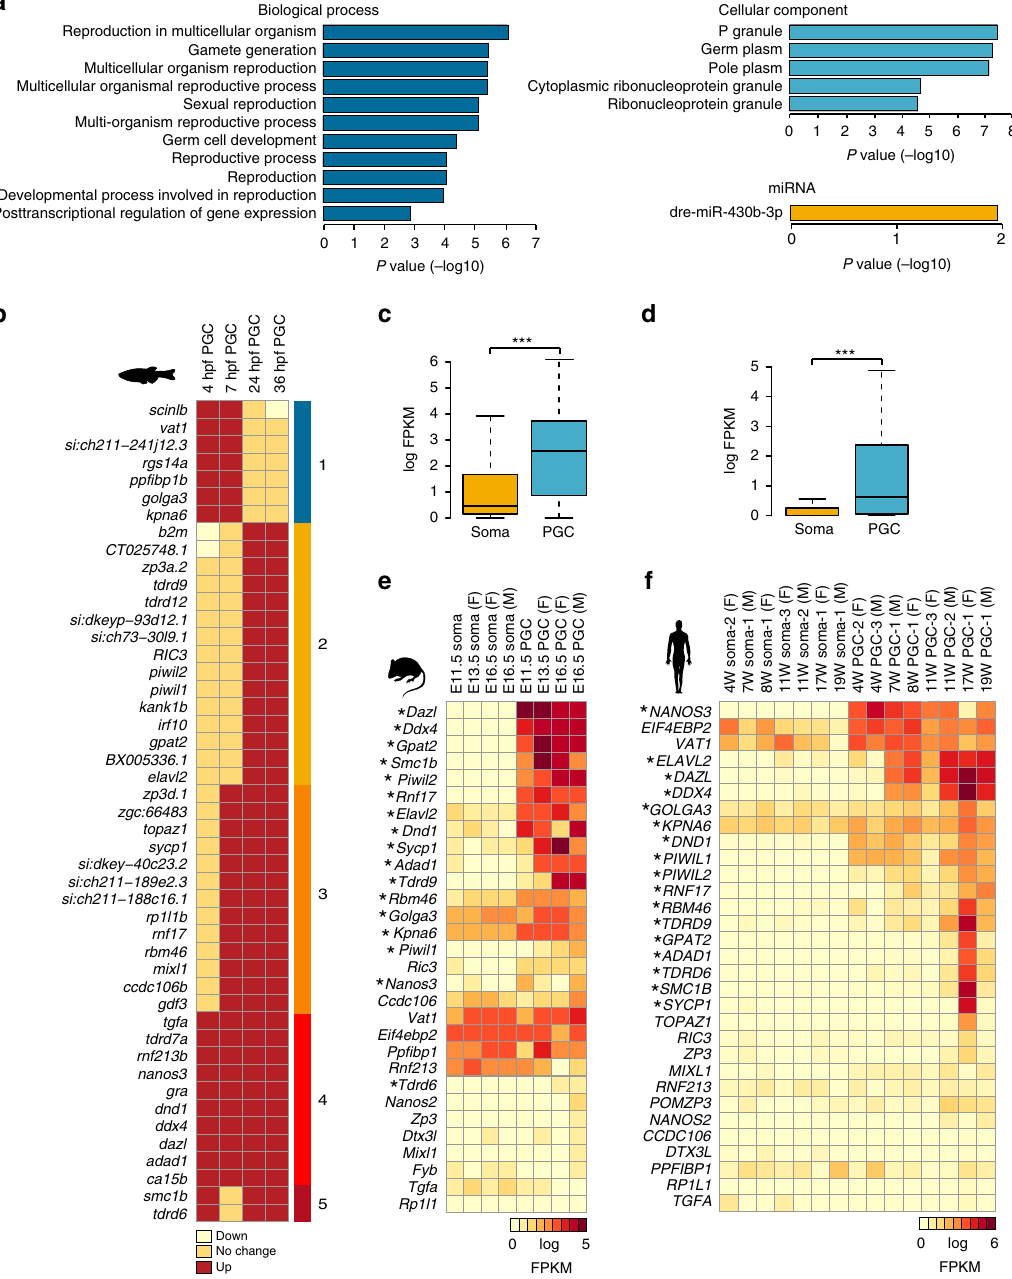
Fig. 4 Evolutionary conservation of transcriptional programmes in vertebrate primordial germ cells (PGCs). a Gene ontology enrichment (Biological Process, Cellular Component, and miRNA binding sites) analysis of genes consistently upregulated in PGCs compared to corresponding somatic cells. b Heatmap showing the dynamics of fold changes of genes that display higher transcript abundance in PGCs in at least two consecutive developmental stages: up — upregulated in PGCs (log FC >1.5, false discovery rate (FDR) <0.05), down — downregulated in PGCs (log FC < − 1.5, FDR <0.05). c , d Boxplots showing log-transformed FPKM (fragments per kilobase million) expression values of the orthologues of putative germline regulators in mouse ( c ) and human ( d ) PGCs and somatic cells ( p value <0.001, Student ’ s t test). The boxes show the interquartile range (IQR) around the median. The upper and lower whiskers extend from the hinge to the largest and smallest value, respectively, no further than 1.5 IQR. e f Heatmaps showing log-transformed FPKM expression values of putative germline regulators across mouse ( e ) and human ( f ) development, for PGCs and somatic cells. Asterisks indicate genes with evolutionarily conserved PGC-speci fi c expression patterns (conserved in fi sh, mouse and